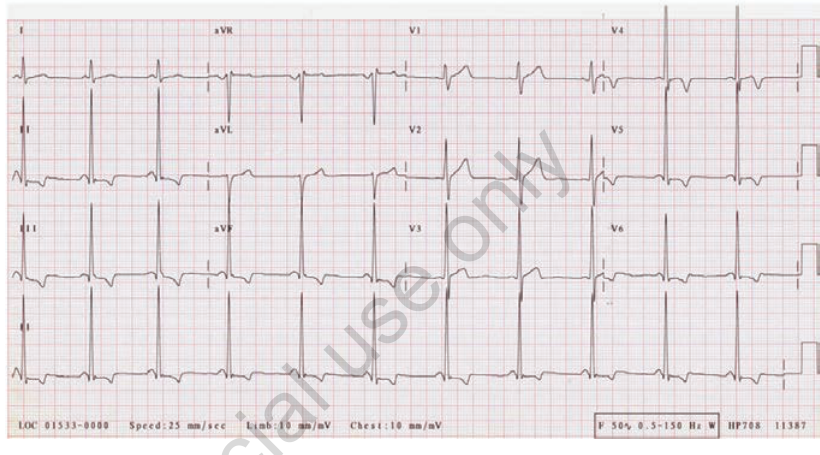
Figure 4. Electrocardiogram in a male patient with Anderson-Fabry disease showing left ventricular hypertrophy with T-waves inversion and a relatively short PR (133 ms) ( Reprinted with permission of the publisher from O’Mahony and Elliott 46 ).